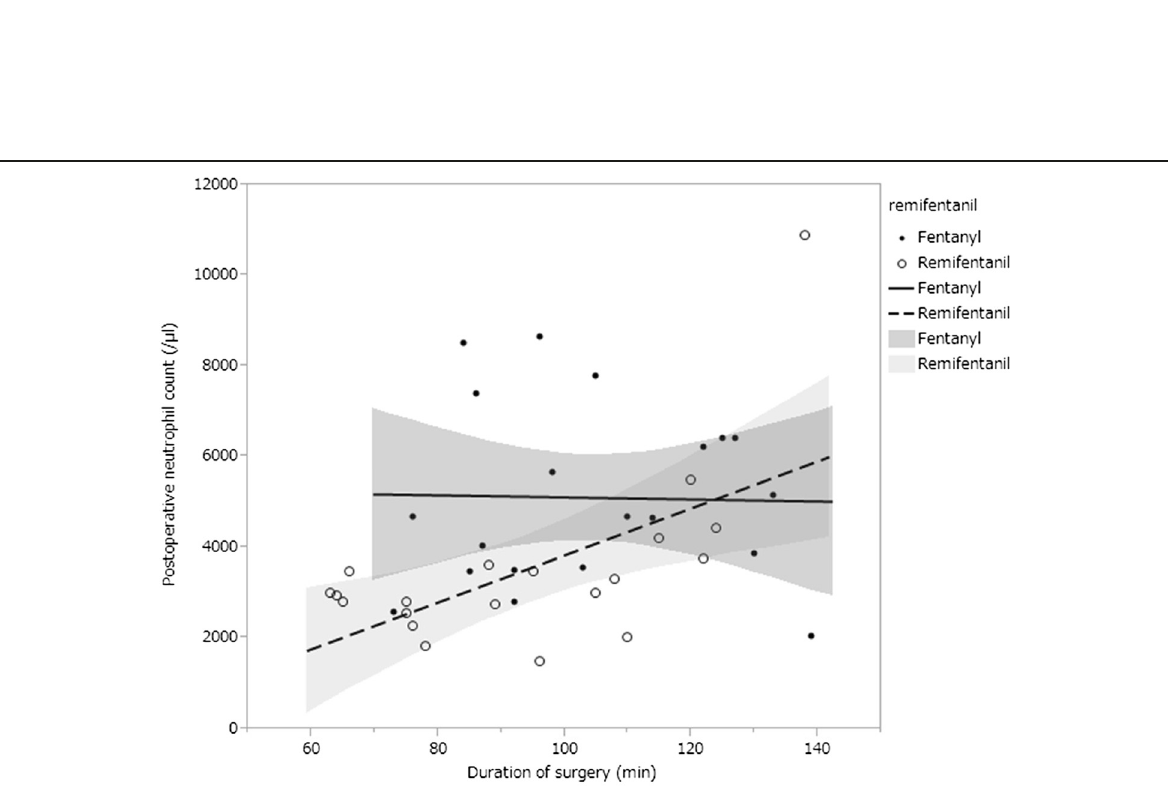
Fig. 2 Correlations between the postoperative neutrophil count and duration of surgery in fentanyl group (thick line and dark shadow), and between the postoperative neutrophil count and duration of surgery in remifentanil group (dotted line and light shadow). The dark shadow represents the 95 % confidence interval (CI) in fentanyl group and the light shadow represents the 95 % CI in remifentanil group. Neutrophil count =5335-2.2*duration of surgery (min). R 2 = 0.00, P = 0.92 (Fentanyl group). Neutrophil count = -1349 + 51.8*duration of surgery (min). R 2 = 0.36, P = 0.0044 (Remifentanil